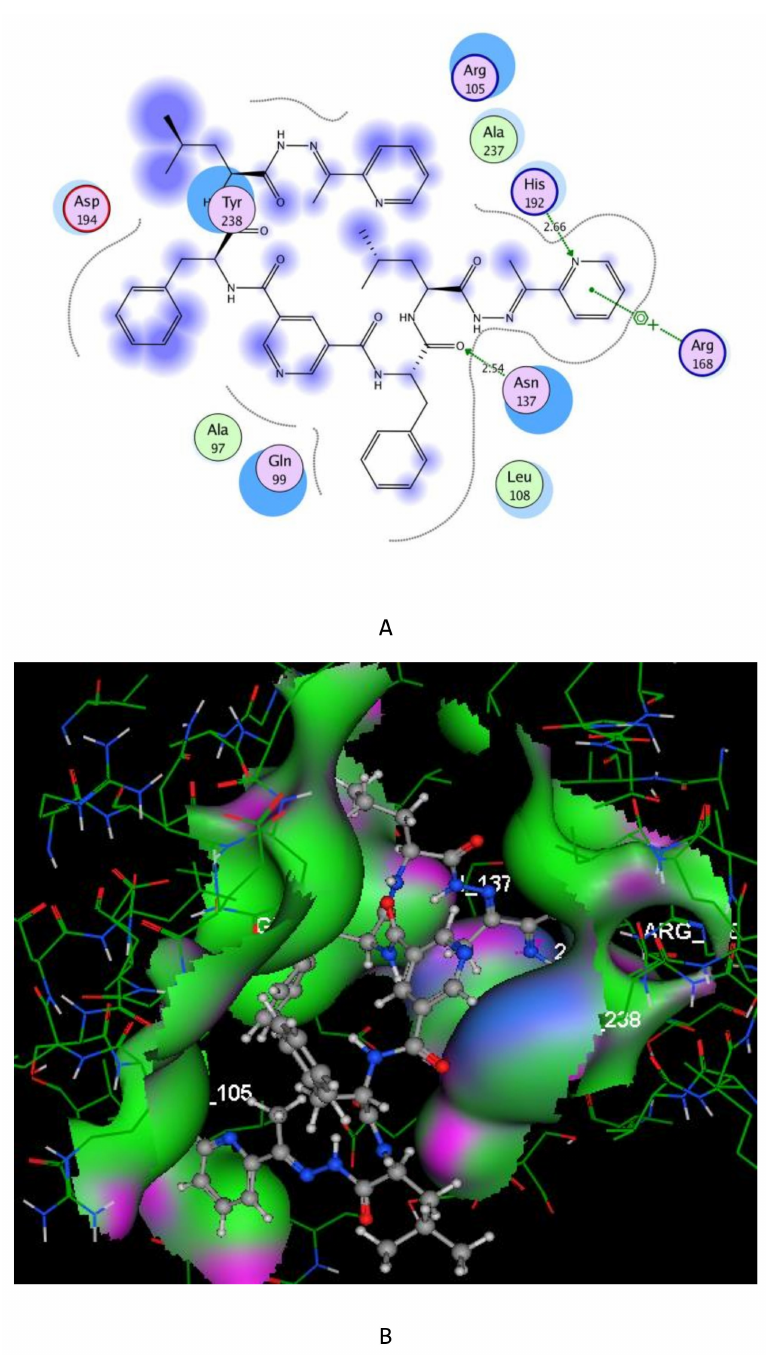
Figure 7. Two-dimensional ( A ) and 3D ( B ) patternsillustrating the proposed binding mode of the compound 4a in the LDHA binding pocket (PDB code: 4ZVV). Hydrogen bonding interactions with the protein are shown as dashed lines. Green color reflects a hydrophobic area, pink color reflects a high polar area, and blue color reflects a mild polar